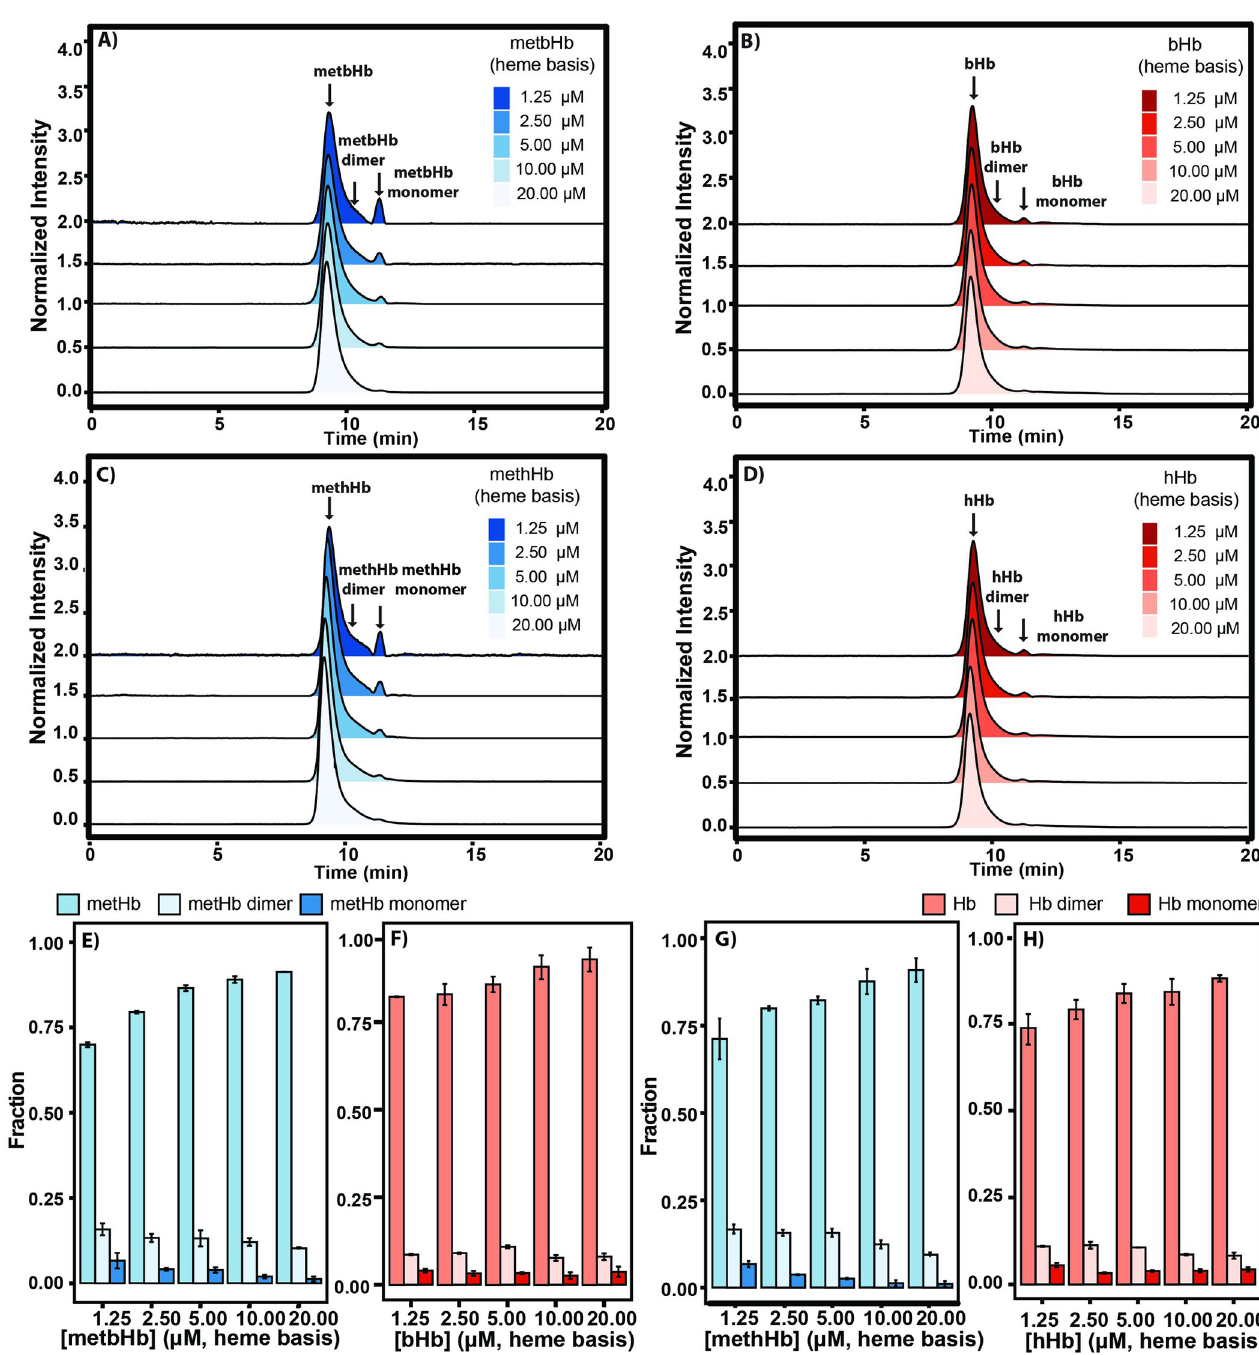
Fig 7. SEC-HPLC of metHb/Hb as a function of metHb/Hb concentration to monitor metHb/Hb dissociation after 1 week of storage at 4˚C. Normalized intensity SEC-HPLC chromatograms of (A) metbHb, (B) bHb, (C) methHb, and (D) hHb. Chromatograms were monitored at an absorbance of λ = 413 nm normalized against the total area under the curve. Composition of (E) metbHb, (F) bHb, (G) methHb, and (H) hHb species including the metHb/Hb tetramer ( α 2 β 2 ), metHb/Hb dimer ( αβ ) and monomer ( α / β ) as a function of metHb/Hb concentration. (The error bars represent the standard deviation from duplicate experiments.)